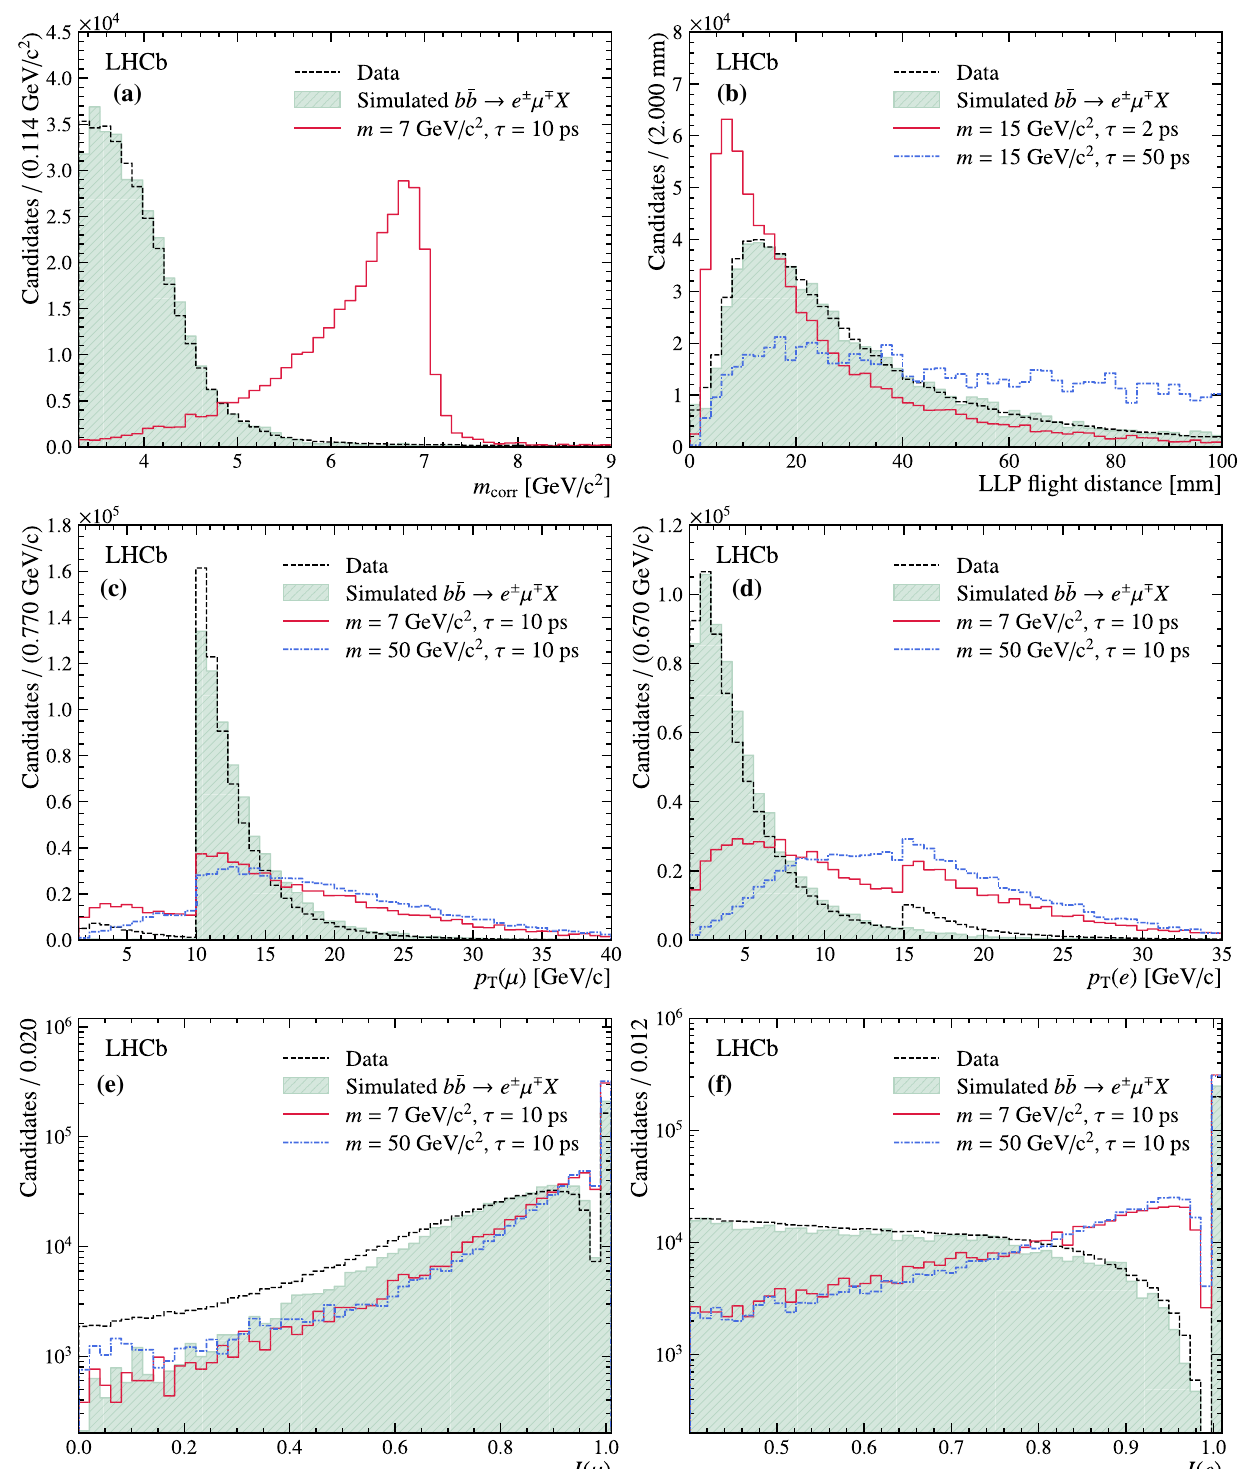
Fig. 2 Distributionsindata(dashedblackhistogram)comparedtosim- ulated bb → e ± μ ∓ X (green filled histogram), showing, a m corr , b the LLP flight distance, c the transverse momentum of the muon, d the transverse momentum of the electron, e the isolation of the muon, and f the isolation of the electron. LLP signal distributions are also shown (coloured histograms) for different m LLP and τ LLP values, where the